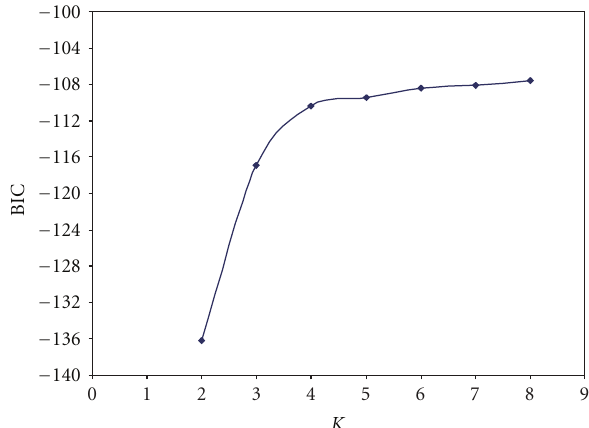
Figure 2: Plot of BIC values for experimental phantom data set, scaled by a factor of 1000.